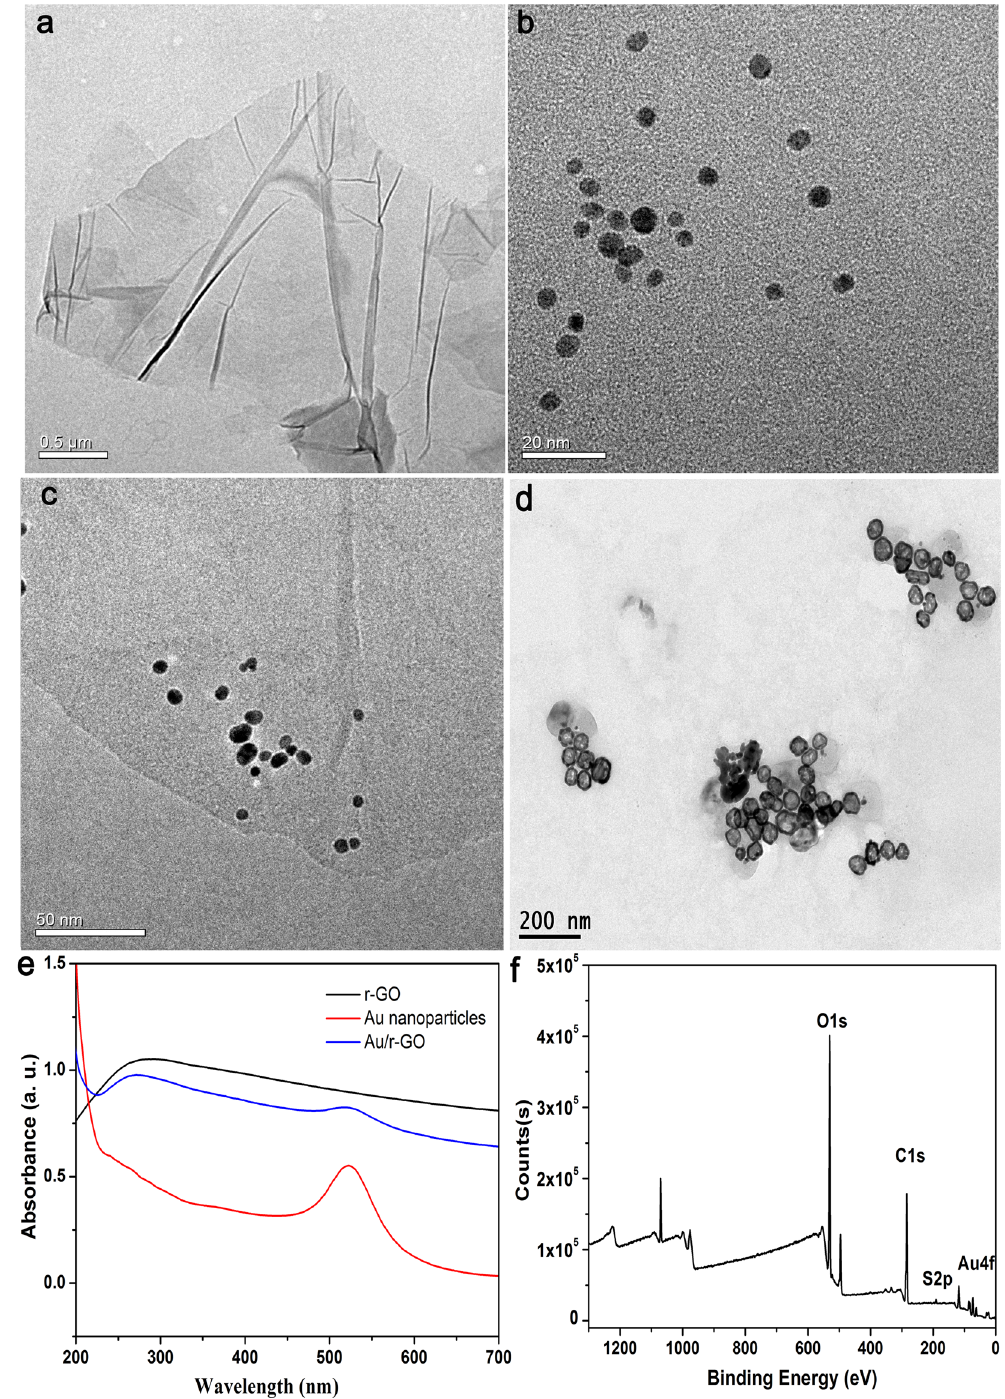
Figure 2. TEM images of r-GO ( a ); Au nanoparticles ( b ); Au/r-GO nanocomposites ( c ); Au nanoparticles ( d ); Ultra-vis absorption spectrum of the r-GO, Au nanoparticles and Au/r-GO nanocomposites ( e ); XPS survey spectra of the prepared Au/r-GO nanocomposites ( f